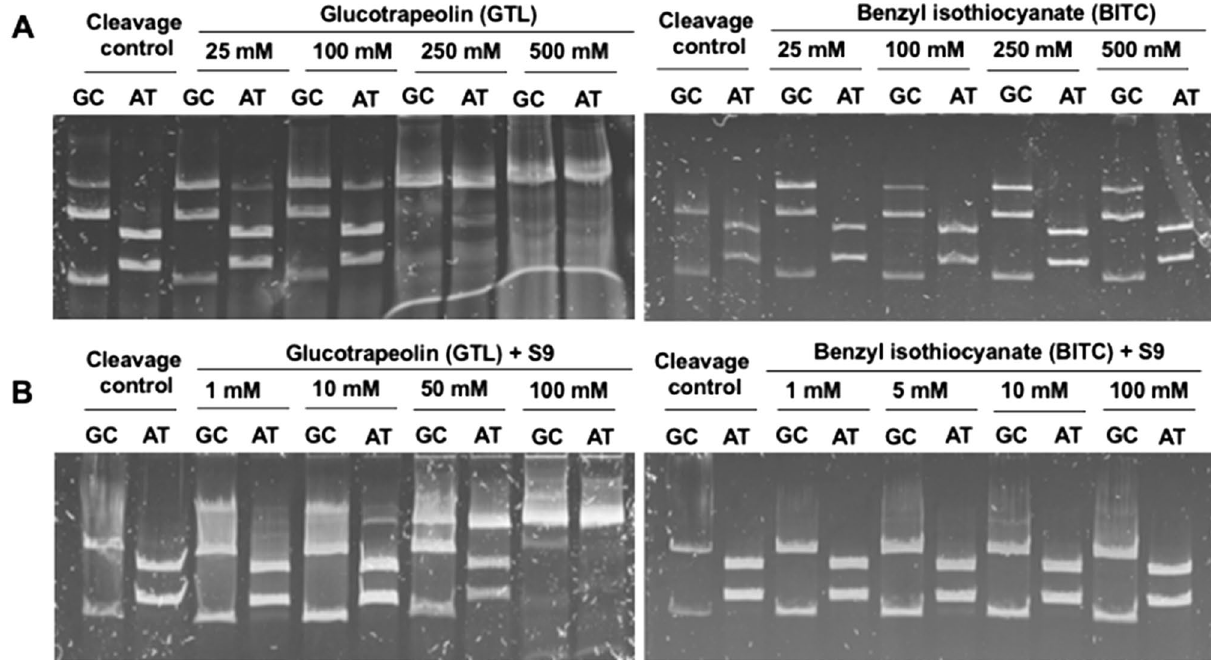
Figure 8. DNA fragments generated as a result of endonucleolytic cleavage of DNA amplicon with HpaII (GC-specific) or Tru1I (AT-specific) enzymes. ( A ) DNA amplicon incubated for 2 h at 37 °C with increasing glucotrapeolin (GTL) or benzyl isothiocyanate (BITC) concentrations before restriction analysis was performed as described in the “Materials and methods” section. DNA amplicon incubated with water or DMSO in place of the tested compounds served as control. ( B ) GTL and BITC were pre-incubated for 15 min at 37 °C with an S9 mixture for the metabolic activation of tested compounds. Then DNA amplicon was added to each sample and incubated for 30 min at 37 °C and restriction analysis was performed as described in the “Materials and methods” section. DNA amplicon incubated with water or DMSO in place of the test compound solution served as